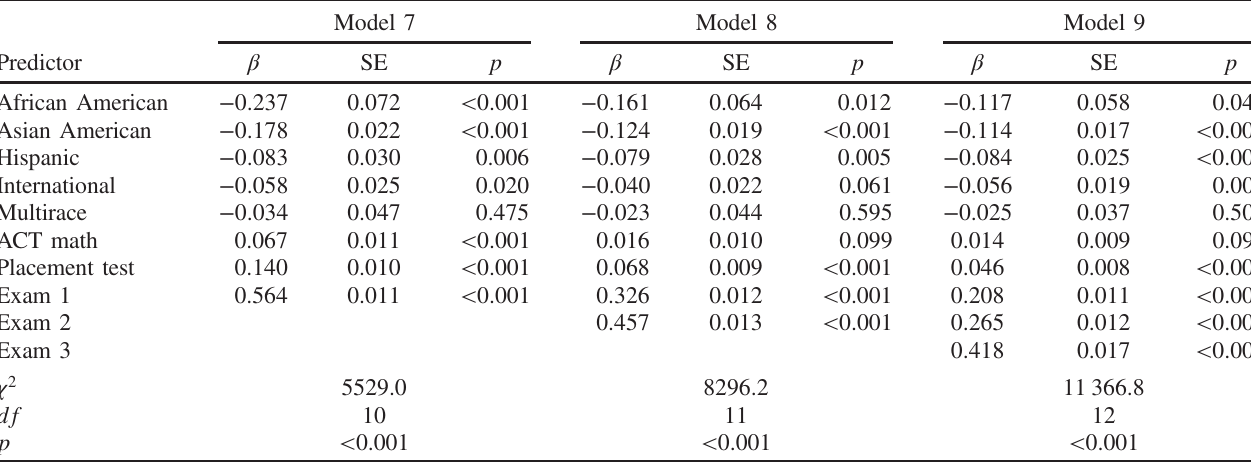
TABLE VII. Models with course exam scores predicting physics 1 final exam scores.